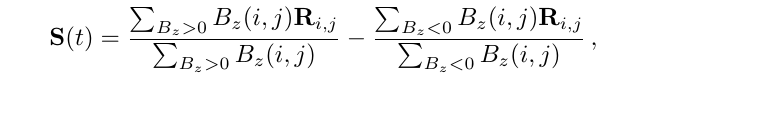
characterises compactness, the eff